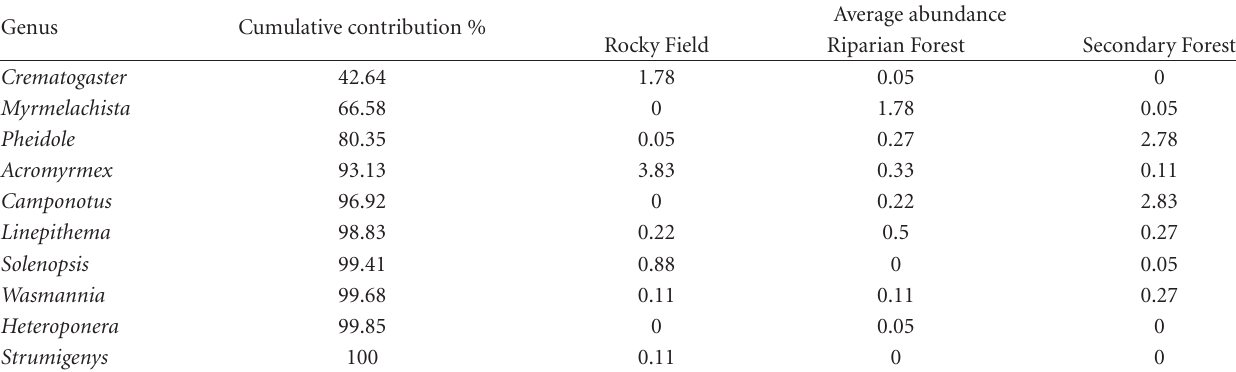
Table 4: Cumulative contribution of ant genera for the dissimilarities among the phytophysionomies (SIMPER) sampled at Parque Estadual do Ibitipoca, Brazil. July–December,